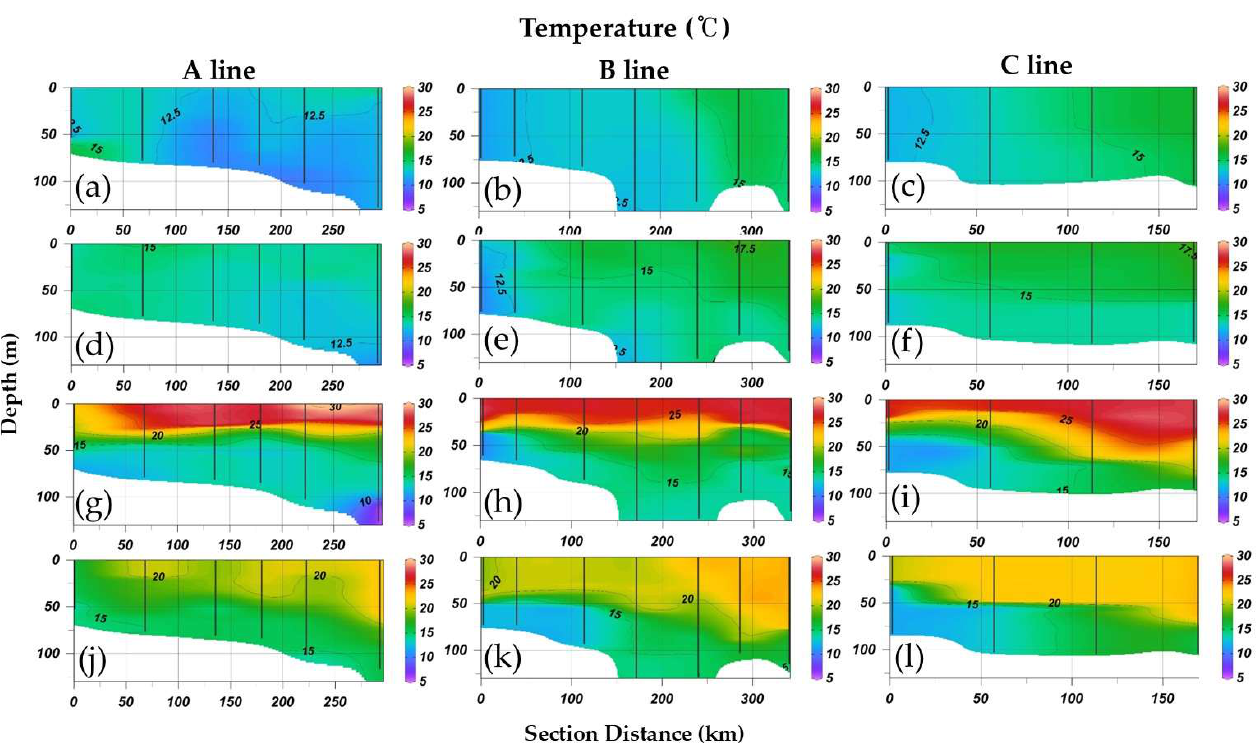
Figure 2. Vertical distribution of water temperature (°C) in ( a – c ) February, ( d – f ) April, ( g – i ) August, and ( j – l ) October 2018. Lines A, B, and C represent north-to-south sampling lines in the study area.